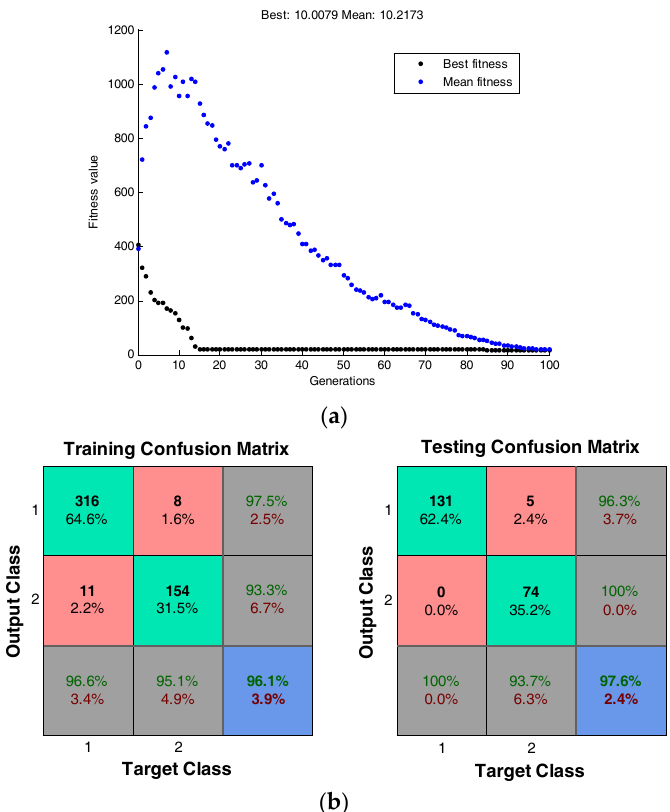
Figure 7. Simulation results of the GA-BEL on the Breast Cancer dataset. ( a ) Fitness curve during evolution; ( b ) classification confusion matrix for training and testing samples.